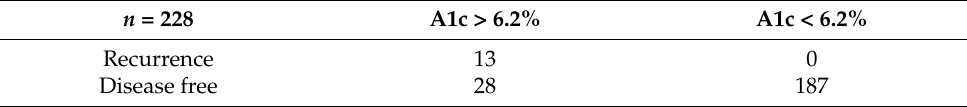
Table 6. Distribution of patients with recurrence depending on A1c levels two years after surgery.